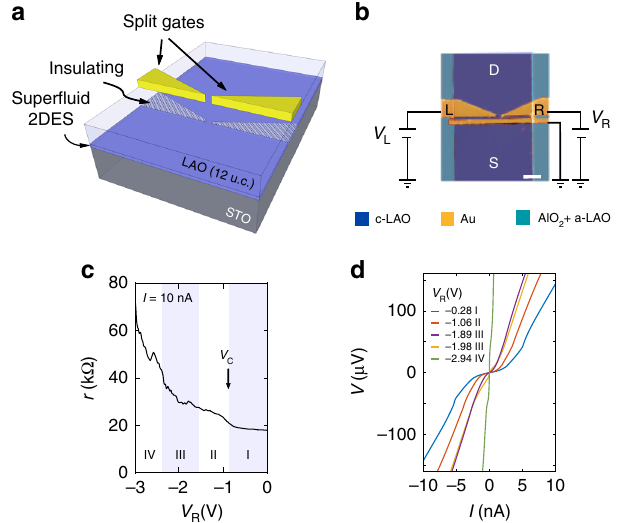
Fig. 1 Two-dimensional superconductor with split gates. a Generalized sketch of the device. At the interface between the STO substrate and the 12 unit cell (u.c.) layer of crystalline LAO (c-LAO) the superconducting 2DES (blue) is formed, which can be tuned insulating (shaded blue) locally under the split gates (yellow), thus forming a superconducting constriction. b False color atomic force microscope image showing the device layout. The potential of the split gates (yellow) L and R is controlled with the voltages V L and V R , respectively. V L is kept at − 1 V. The conductive 2DES is formed in regions with c-LAO (blue). In areas which are protected with an AlO 2 hard mask LAO growth is amorphous (a-LAO, turquoise). The thin gate spanning the channel is not used in the experiments. It is therefore kept at ground potential. Scale bar = 1 μ m. c High bias ( I = 10 nA) differential resistance r as a function of V R . I, II, III, and IV indicate the different regimes of transport (see text). V c denotes the formation of the constriction. d I – V curves for different gate voltages V R with V L = − 1 V. I – IV refer to the different regimes of transport indicated in Fig. 2. For regime III two curves are shown with a high and a low zero bias resistance,